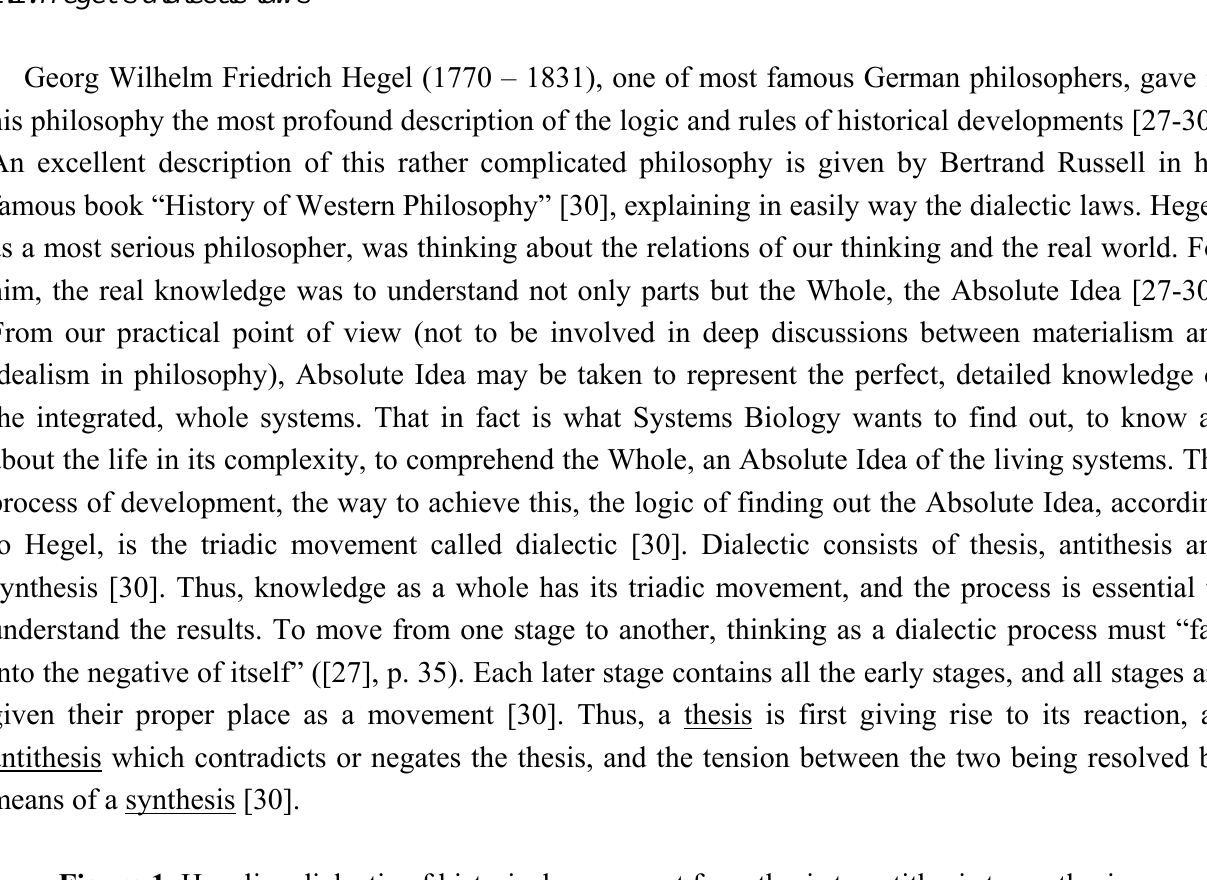
Figure 1. Hegelian dialectic of historical movement from thesis to antithesis to